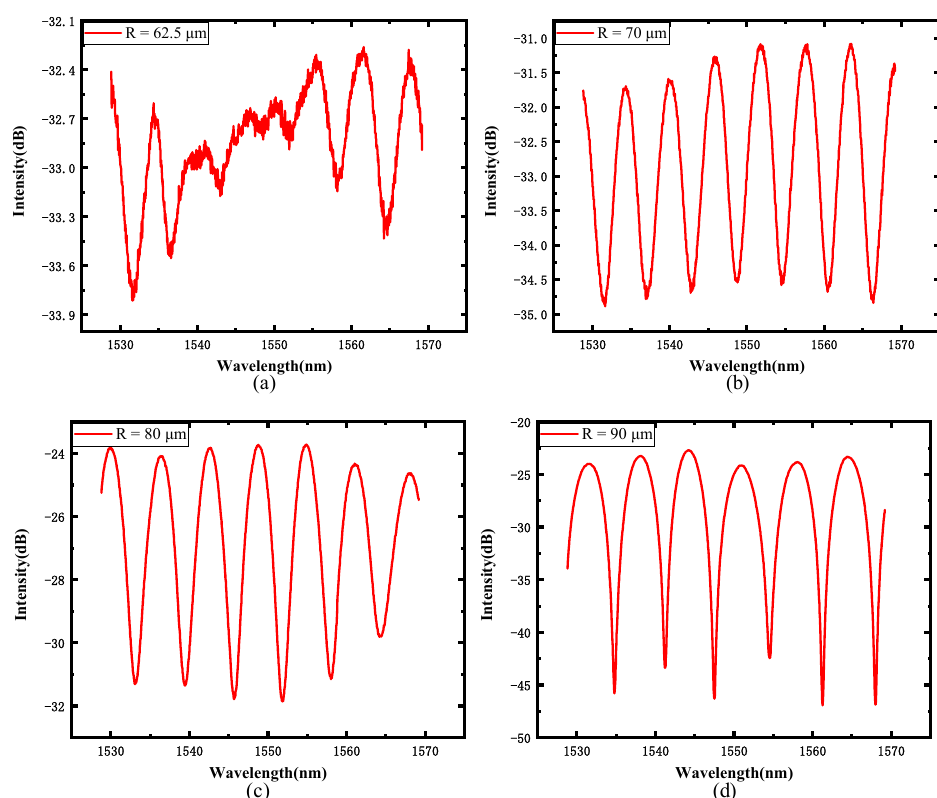
Figure 13. Sensors’ spectra: ( a ) radius is 62.5 μ m, ( b ) radius is 70 μ m, ( c ) radius is 80 μ m, and ( d ) radius is 90 μ m.